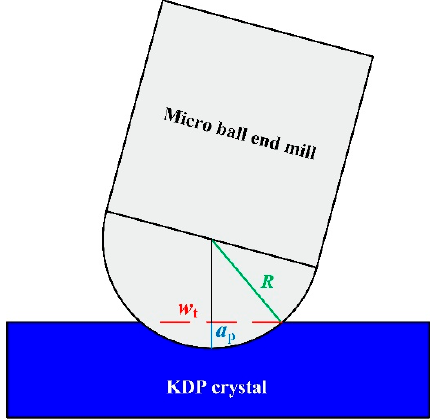
Figure 2. The diagram of micro ball end-milling process.